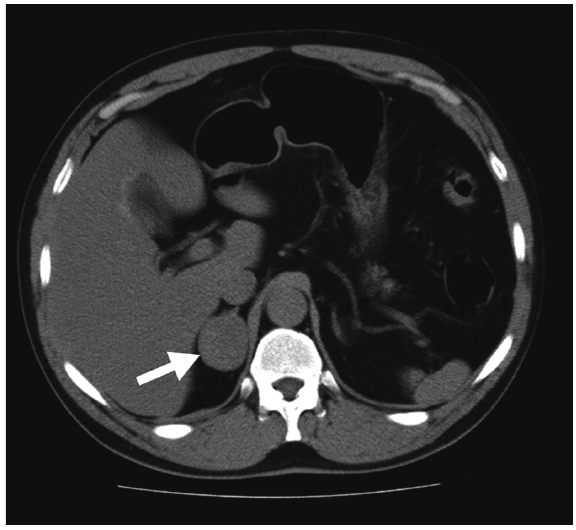
Figure 1: Computed tomography showing a mass in the right adrenal gland